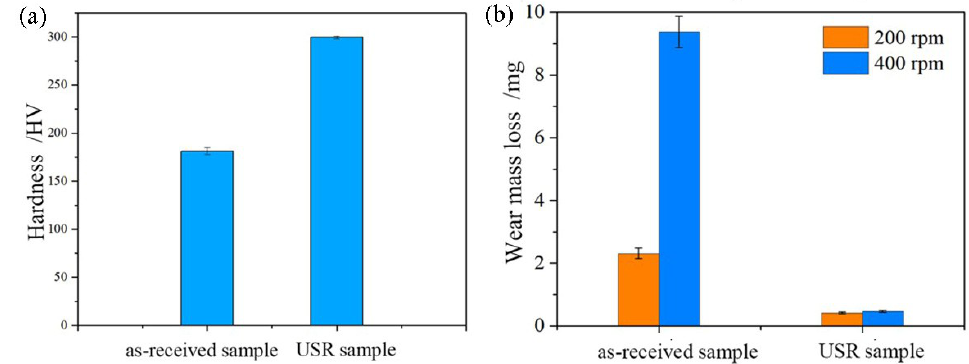
Figure 5. The hardness ( a ) and wear mass loss ( b ) of the USR sample, compared to as-received sample.